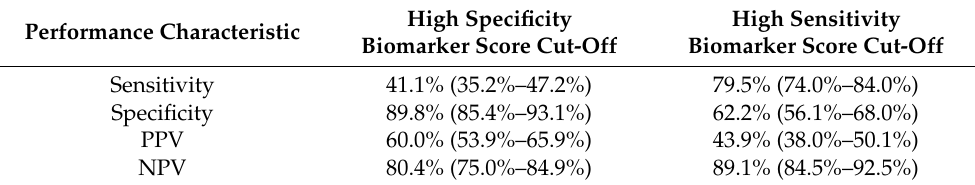
Table 3. Performance of optimal 6-miRNA biomarker